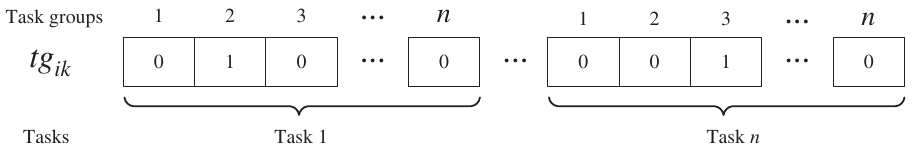
Figure 5: A Coding